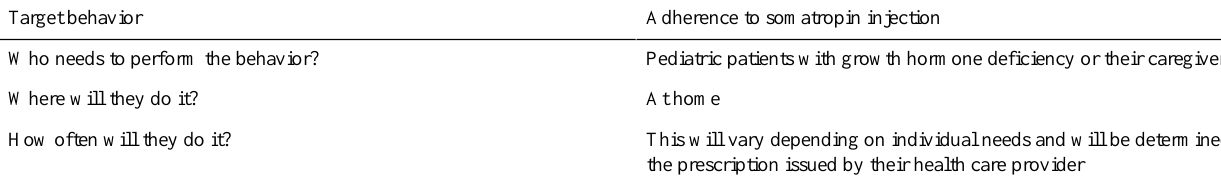
Table 1. Target behavior